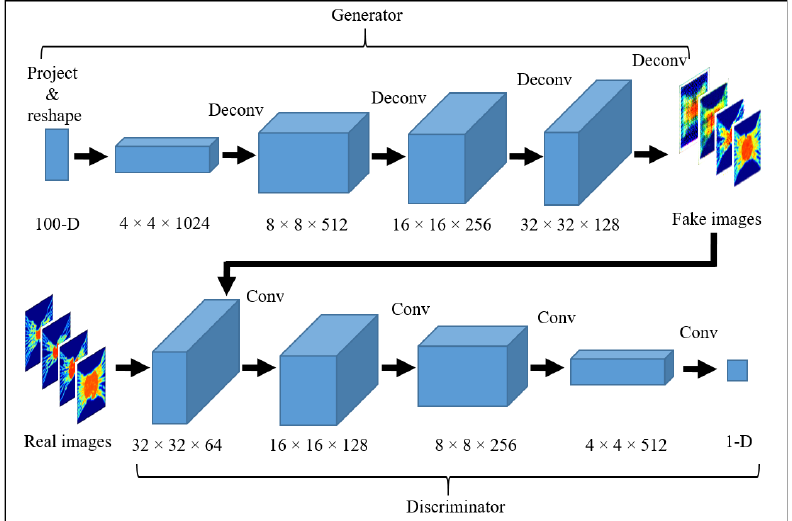
Figure 2. Generator and discriminator architectures are used to generate synthetic or fake 18F-FDG PET images. A series of four fractionally-strided convolutions (i.e., deconvolutions) as a generator to convert a vector of random 100-dimensional uniform distribution into a 64 × 64 × 3 pixel image, and then the discriminator takes these generated images and 1,700 input images of size 64 × 64 × 3, which are generated previously using biomathematical modeling, and calculates the likelihood probability (0,1) score values using four convolution layers to distinguish the synthetic and real 18F-FDG PET images.